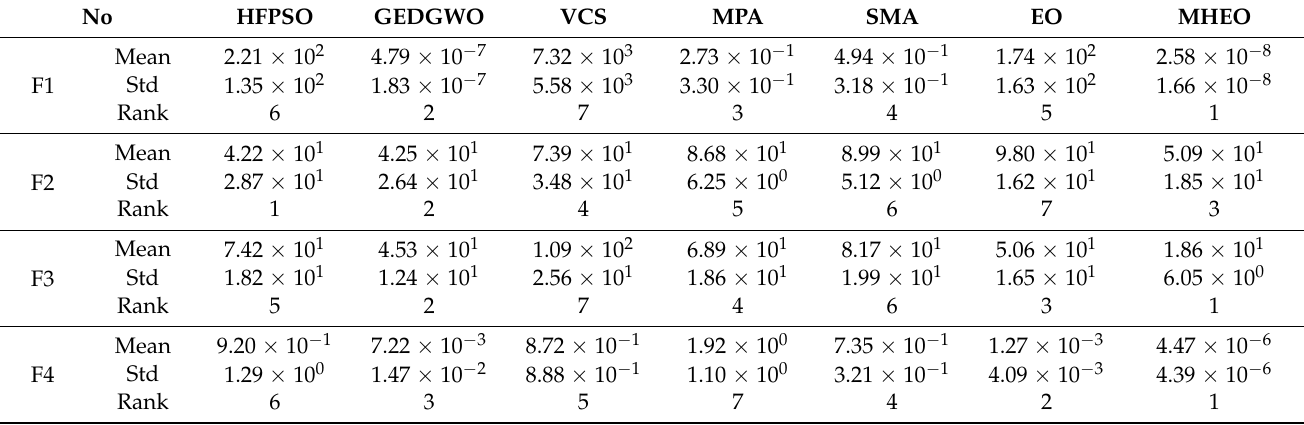
Table A1. Results statistics of seven algorithms in the CEC2017 30D